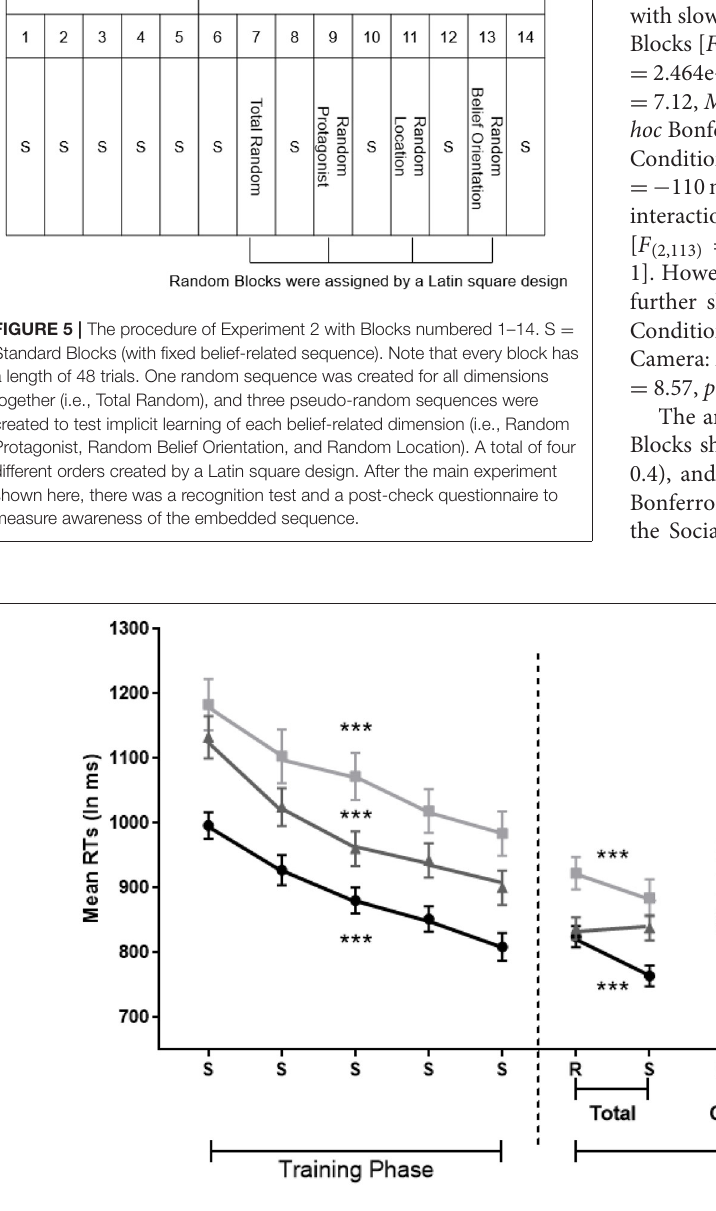
Frontiers in Psychology |